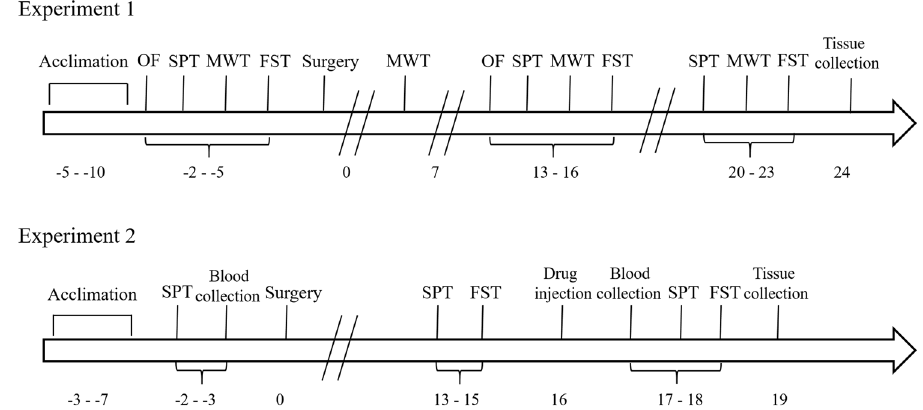
Figure 1. Schedule of behavioral tests and drug